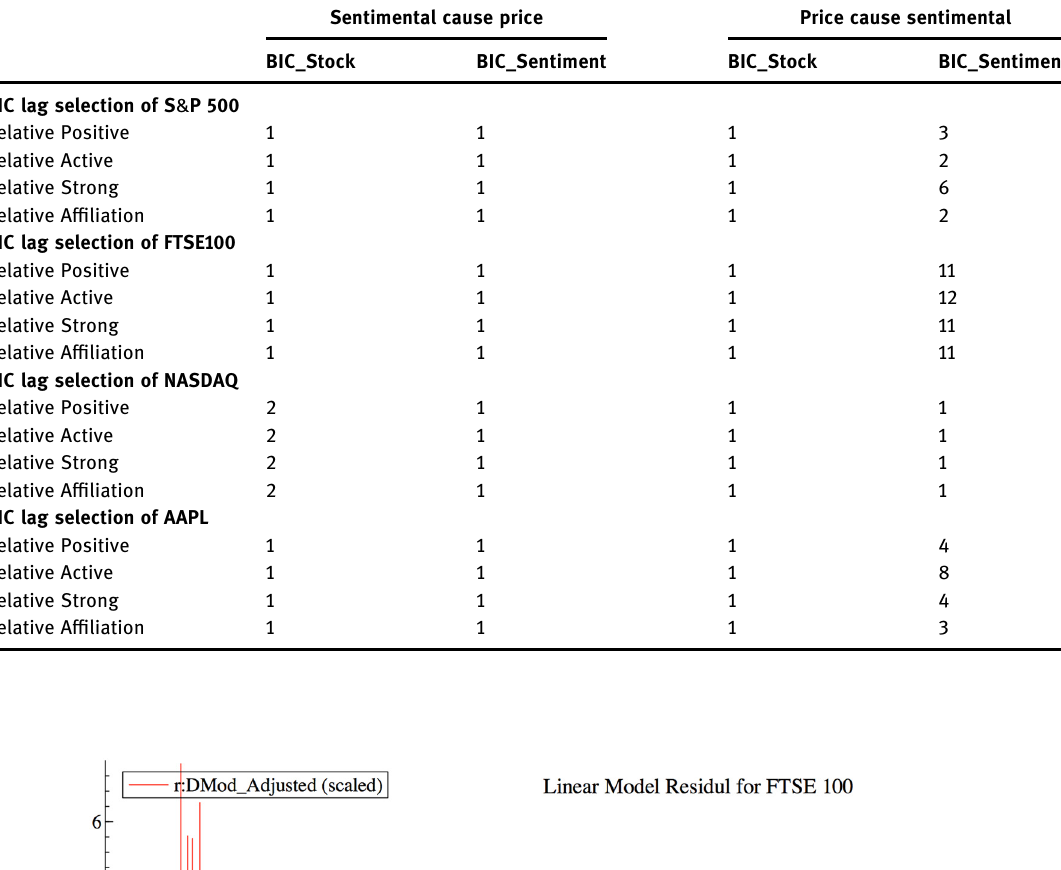
Table A2: BIC lag length selection